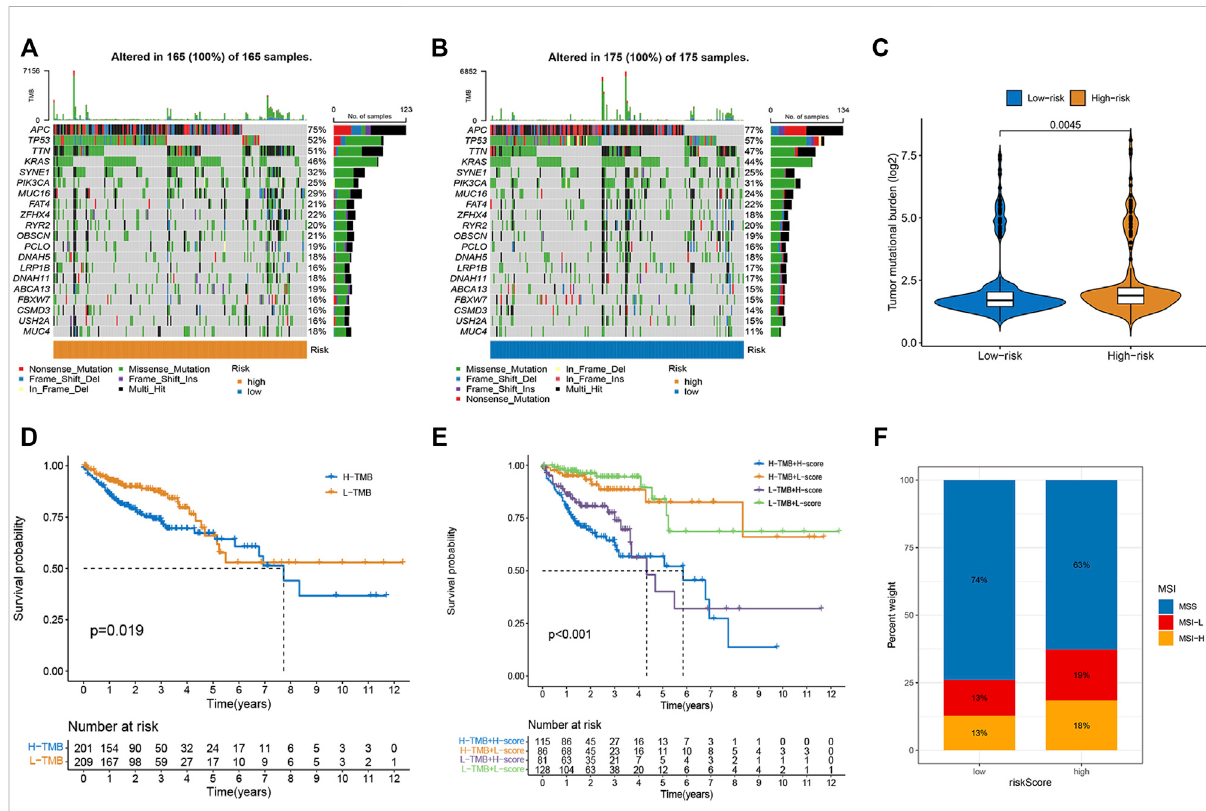
FIGURE 5 Correlations of risk score with TMB and MSI in CRC. (A,B) The mutation rate and types of top 15 genes in low- and high-risk groups. (C) The difference in TMB between high- and low-risk group. (D) Kaplan-Meier curve to show survival of patients in different TMB groups. (E) Kaplan-Meier survival curves to show the survival of patients in different risk scores and TMB groups. (F) Differences in the proportion of different microsatellite statuses between two risk